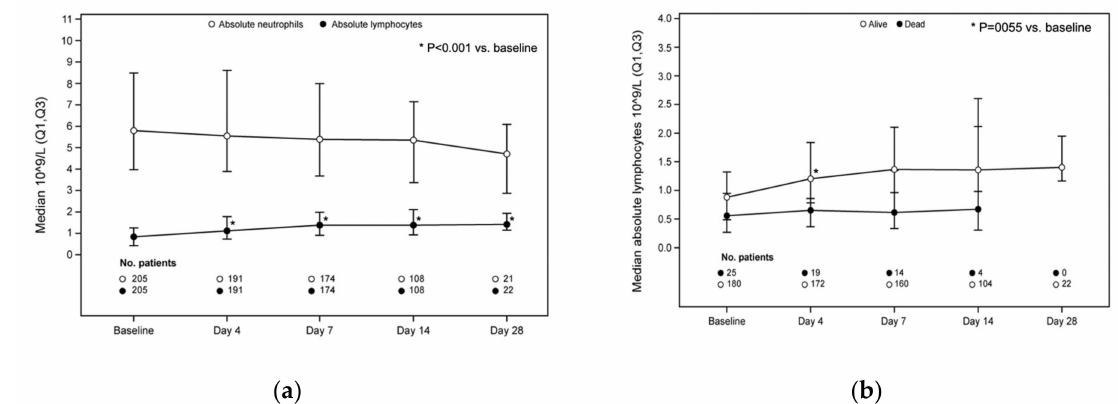
Figure 4. Absolute neutrophils and lymphocytes, and absolute lymphocyte counts according to mortality in the entire population. ( a ) Absolute lymphocyte count: p < 0.0001 at days 4, 7, and 14 vs. baseline; p = 0.0005 at day 28 vs. baseline. ( b ) Correlation between lymphocyte count and mortality at day 4: odds ratio 0.24, 95% CI 0.09–0.66, p = 0.0055 (Wilcoxon signed rank